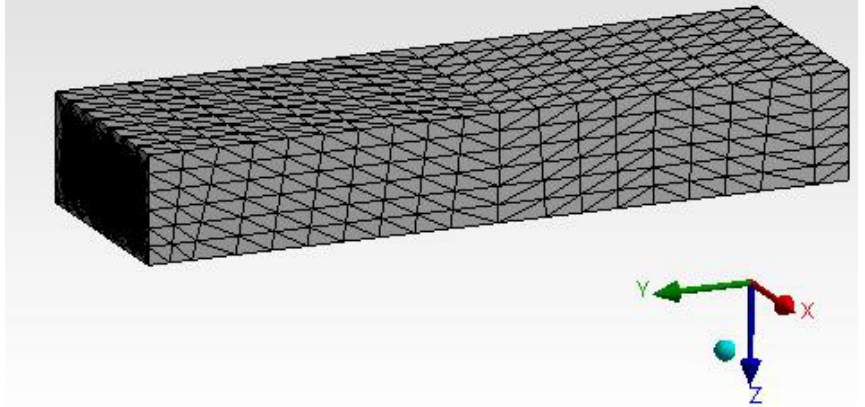
Figure 13. Mapped face meshing.